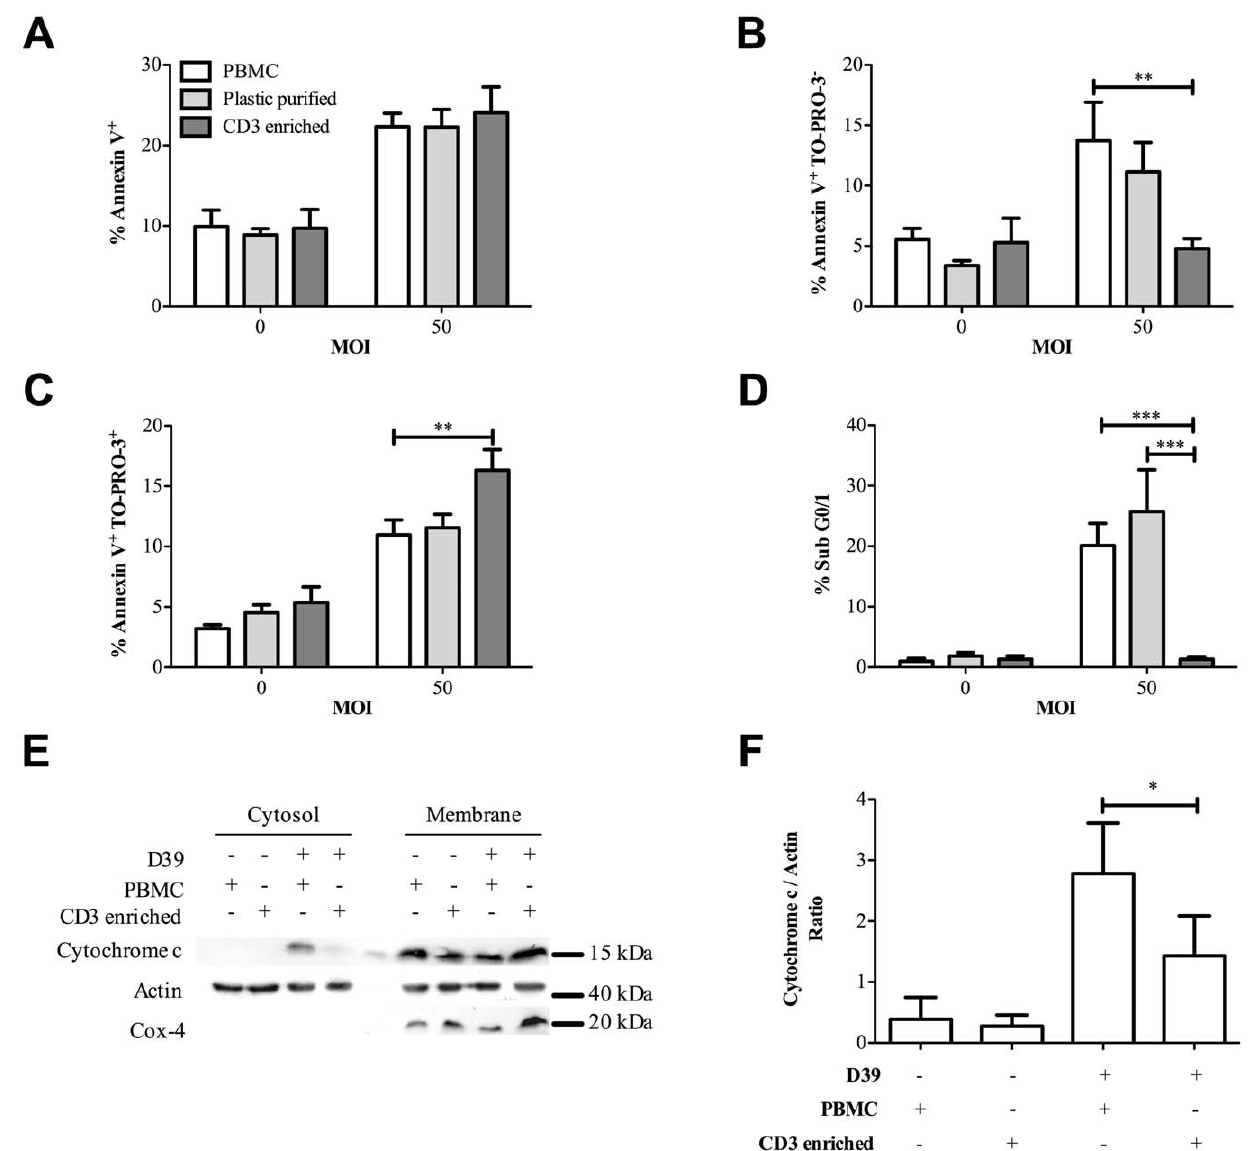
Figure 2. Monocytes induce CD3 + T-cell apoptosis following Streptococcus pneumoniae challenge. Peripheral blood mononuclear cells (PBMC), plastic purified lymphocytes (Plastic purified) and highly purified CD3 + T-cells (CD3 enriched) were challenged for 6 h with either mock- infection (multiplicity of infection (MOI)=0) or D39 Streptococcus pneumoniae (MOI=50). A) Total Annexin V + B) early apoptotic, Annexin V + /TO-PRO- 3 2 and C) late apoptotic/necrotic Annexin V + /TO-PRO-3 + events were recorded, n=11. D) Hypodiploid DNA (Sub G0/1) was measured in CD3 + T-cells under the same conditions, n=5. E) PBMC and CD3 enriched T-cells were challenged with D39 (D39 + ) MOI=10 or mock-infected (D39 2 ) for 16 h. CD3 + T-cells were purified from the PBMC and cytosolic and membrane fractions were obtained from the CD3 + T-cells from each sample prior to western blot analysis probing for cytochrome c, actin and Cox-4 and F) densitometry summarises the cytochrome c/actin ratio for cytosols under each experimental condition, from four experiments with separate